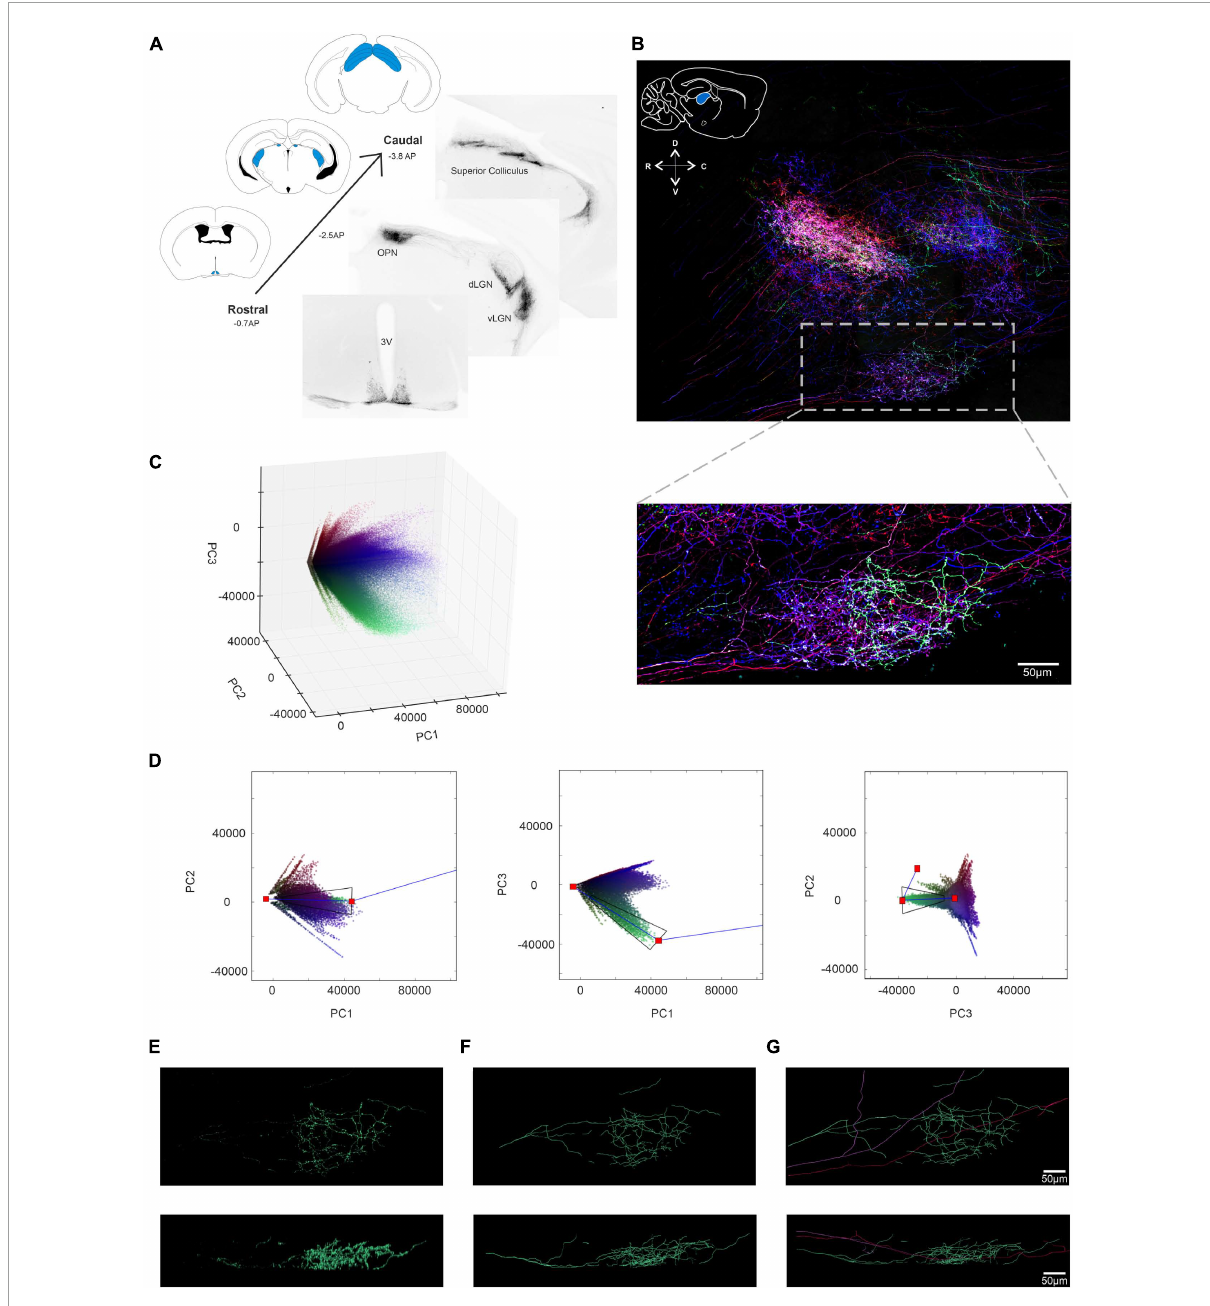
FIGURE6 Using BRIAN to trace axonal projections of ipRGCs in the Lateral Geniculate Nucleus (LGN). (A) Coronal Sections from an Opn4 Cre / + ;rd/rd mouse brain following intravitreal AAV Brainbow injection. Immunohistochemical labeling for the mCherry reporter protein in monochrome reveals strong projections to regions including the SCN (suprachiasmatic Nucleus), OPN (Olivary Pretectal Nucleus), the dorsal and ventral LGN (Lateral Geniculate Nucleus) and the SC (Superior Colliculus). Schematic diagrams from the mouse atlas illustrate the densely stained regions